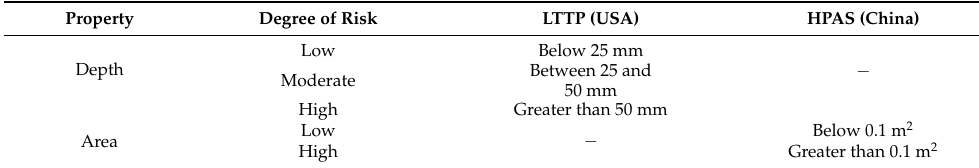
Table 2. Pothole risk classification specified in LTTP and HPAS.